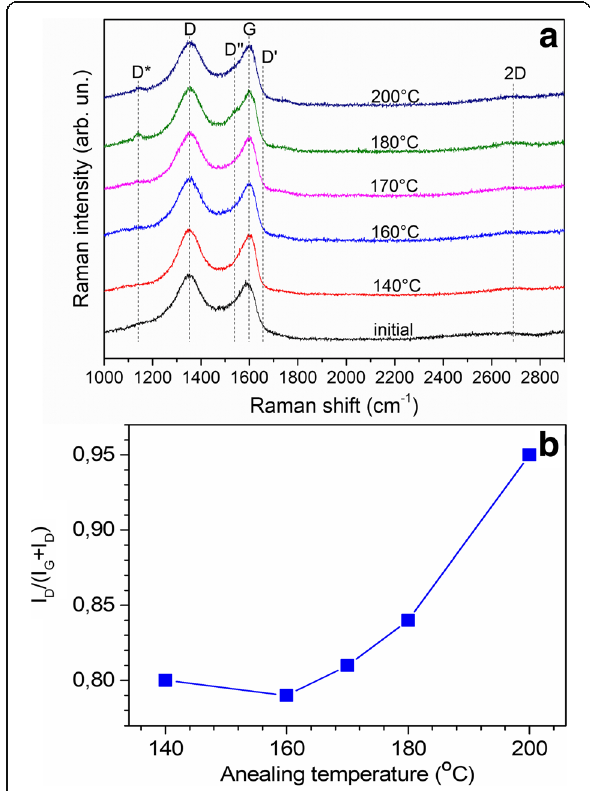
Fig. 4 Normalized and y-shifted Raman spectra for rGO samples of different annealing temperatures ( a ). Dependence of I D /( I G + I D ) ratio on annealing temperature ( b